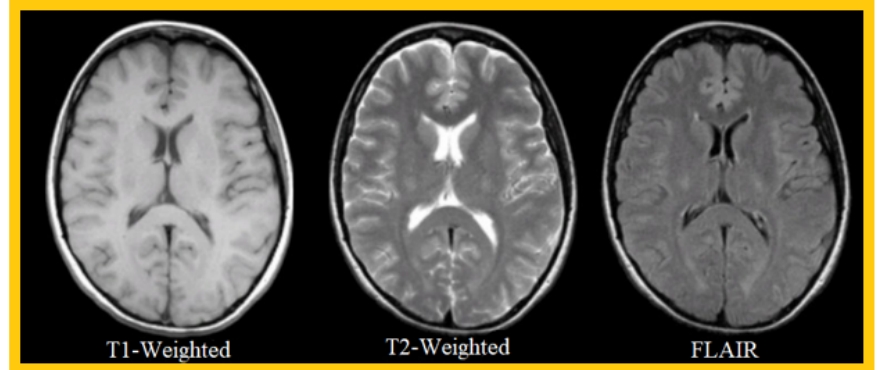
Figure 2. Example of 3 MRI sequences: T1 ‐ Weighted, T2 ‐ Weighted, and FLAIR.